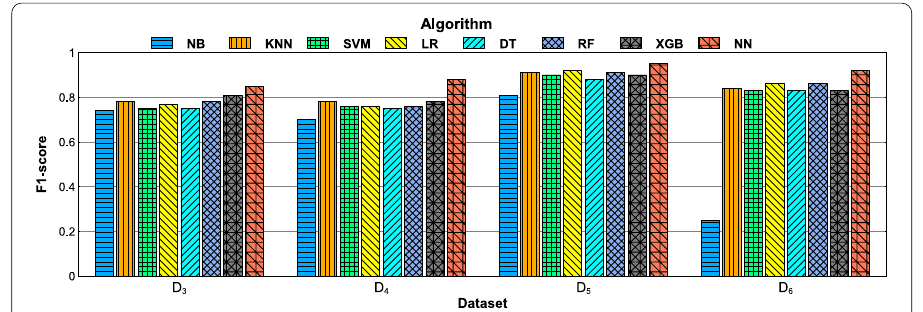
Table 3 Evaluation of the classification models made on the D 2 testset Algorithms Acc Prec Rec F1 Naïve Bayes